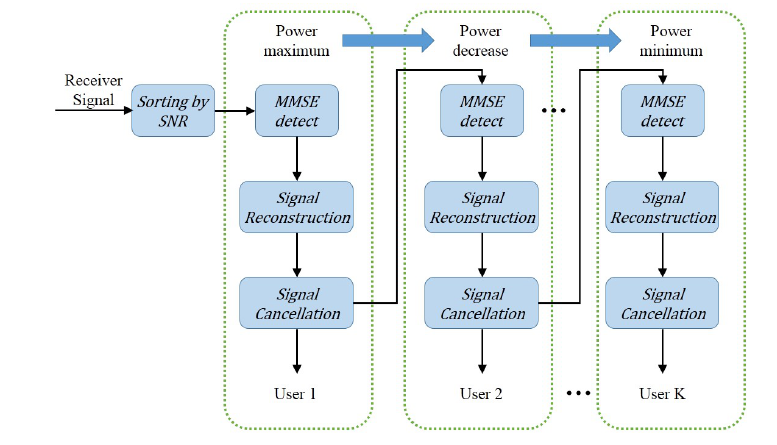
Figure 3. SIC receiver architecture. SNR: signal-to-noise